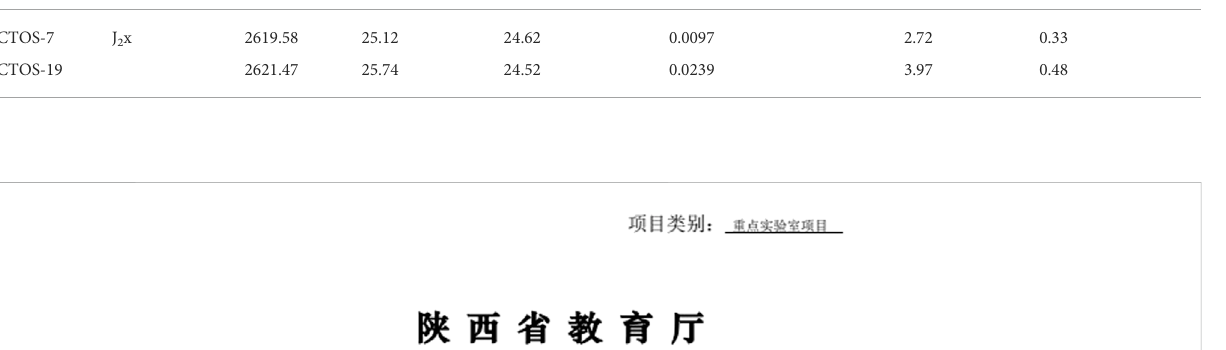
TABLE 1 The basic information of core samples in this study. Core no.